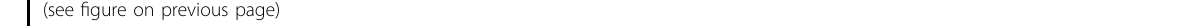
Fig. 6 Identi fi cation of a point mutation in the EHF gene. A Amino acid comparison of a part of the ETS domain is shown in ELF3 (top) and EHF (bottom). Arrowheads indicate mutation previously annotated in the TCGA dataset or previous reports. Identi fi cation of a novel L285P mutation in EHF in breast cancer cells indicated with a red arrow. H.S Homo sapiens , M.M Mus musculus , C.L Canis lupus . B, C, D , and E Expression plasmids for EHF and its derivative mutants were transfected into COS7 cells and examined by IB ( B and E ), immuno fl uorescence ( C ), and luciferase analysis ( D ). F, G , and H TSU and HOC313 cells were infected with lentiviruses carrying control (cont.), fl ag-tagged EHF-SF, or fl ag-tagged EHF-SF-L285P, and subjected to IB analysis ( F ), motility assays using Boyden chamber assay with inserts coated with type I collagen gel (upper panels) and wound healing assays (lower panels) ( G ), and chemoresistance assays ( H ). Each value represents the mean ± s.d. of triplicate determinations from a representative experiment. Similar results were obtained in at least three independent experiments. p values were determined by Student ’ s t -test. ns not signi fi cant; * p < 0.01, ** p < 0.03. α -tubulin was used as a loading control ( B , E , and F